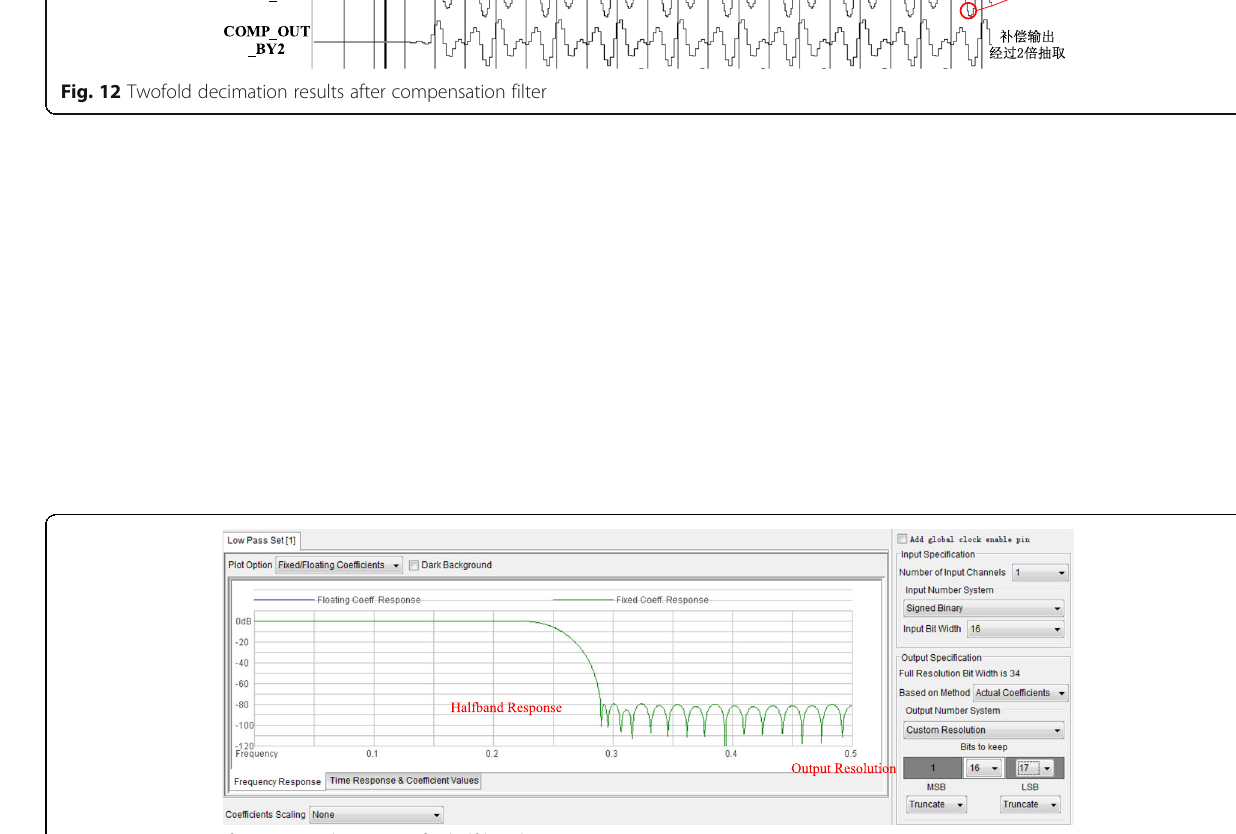
Fig. 13 Device specifications in Altera FPGA for half-band